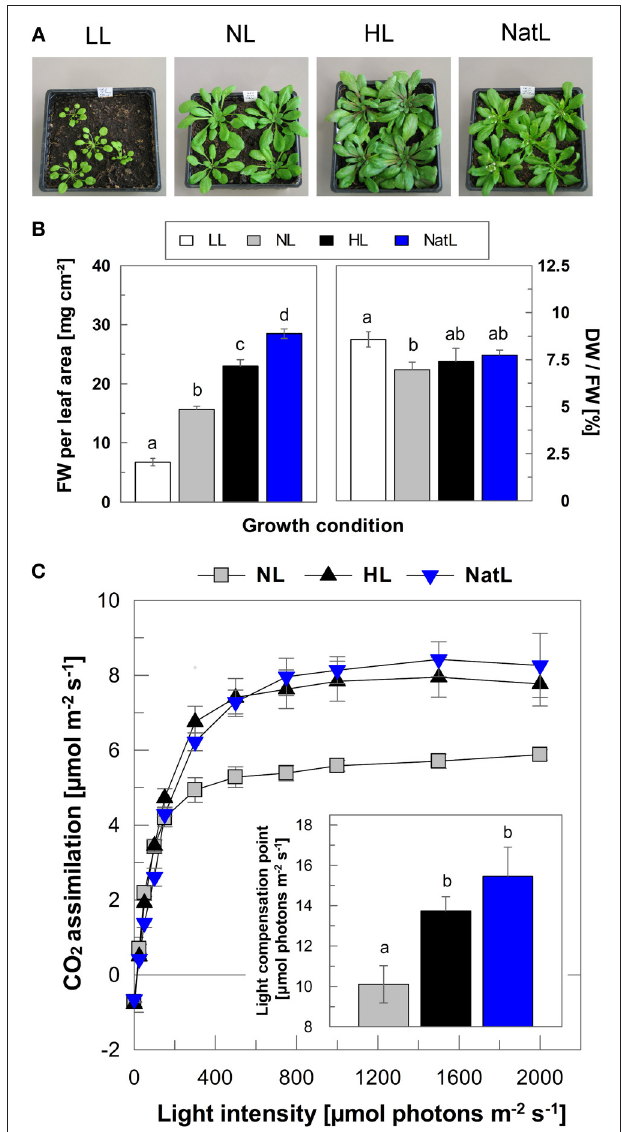
FIGURE 1 | Plant growth and CO 2 assimilation rates. (A) Typical phenotype of 6 weeks-old plants. Please note that 6 weeks-old plants are shown here to illustrate the differences in development, only. All analyses have been performed with about 5 weeks-old plants, and thus before onset of flowering. (B) Fresh weight (FW) of leaves in mg cm − 2 and dry weight (DW) per FW in% (100 × DW/FW). Mean ± SE of six independent samples are shown. Significant differences (Holm-Sidak test, p = 0.05) are indicated. (C) Light response curves of NL, HL, and NatL grown plants. Insert, light compensation point derived from exponential fits of the assimilation curves. Mean values ± SE of 4–6 independent measurements are shown. Significant differences (Holm-Sidak test, p < 0.05) are indicated. Due to their small size, LL plants could not be